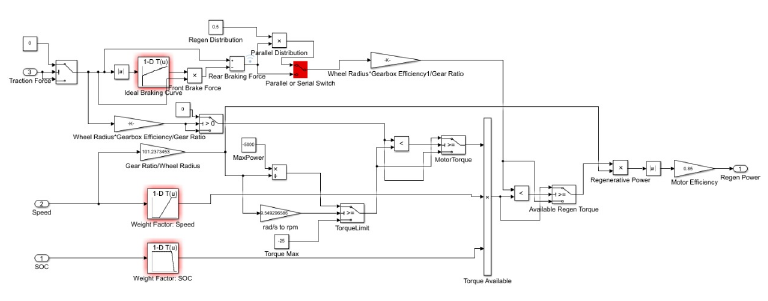
Figure 5. Regenerative braking subsystem block